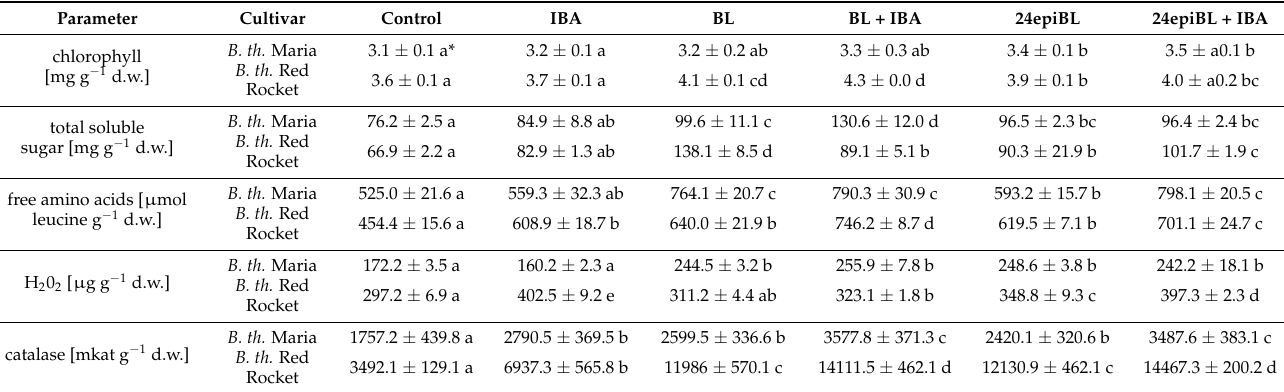
Table 5. Effect of brassinosteroids and auxin IBA on chlorophyll, total soluble sugar, free amino acids, hydrogen peroxide (H 2 O 2 ) contents, and catalase activity in cuttings Berberis thunbergii ‘Maria’ and ‘Red Rocket’. Parameter chlorophyll [mg g − 1